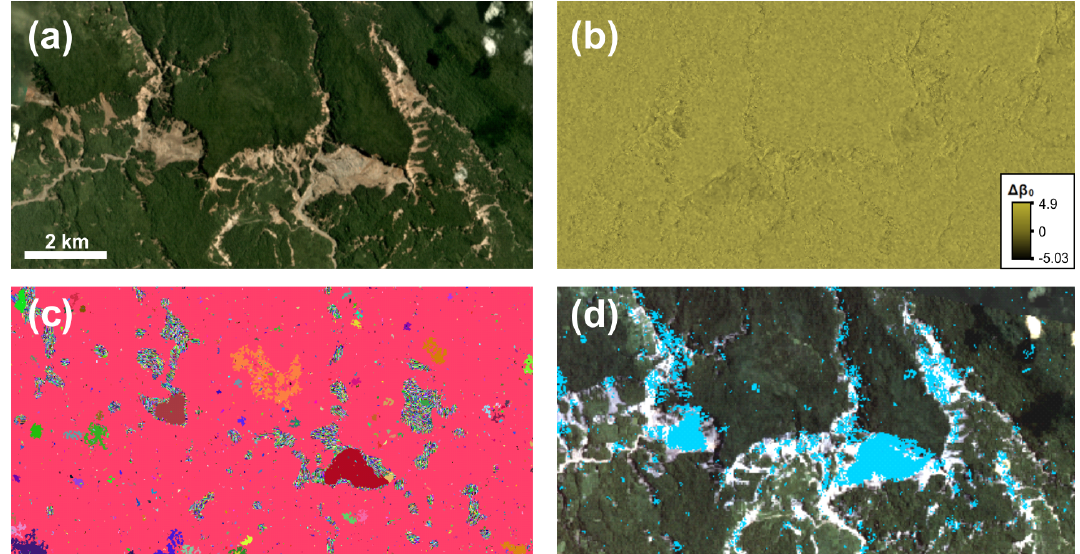
Figure 4. (a) Optical image of a small sample area affected by landslides within the AoI. (b) The corresponding LR layer. (c) Output of the segmentation algorithm (obtained using the optimized hr and th values), where the different colors are random and have the sole purpose of differentiating the different segments. (d) The extracted landslide-related segments (in blue). Optical images have been downloaded from the Planet explorer application (Planet Team,